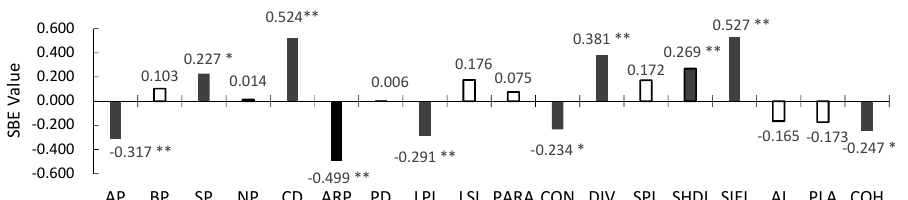
Figure 6. Correlation between color patch structure and SBE value. Note: ** denotes p < 0.01, * denotes p < 0.05.